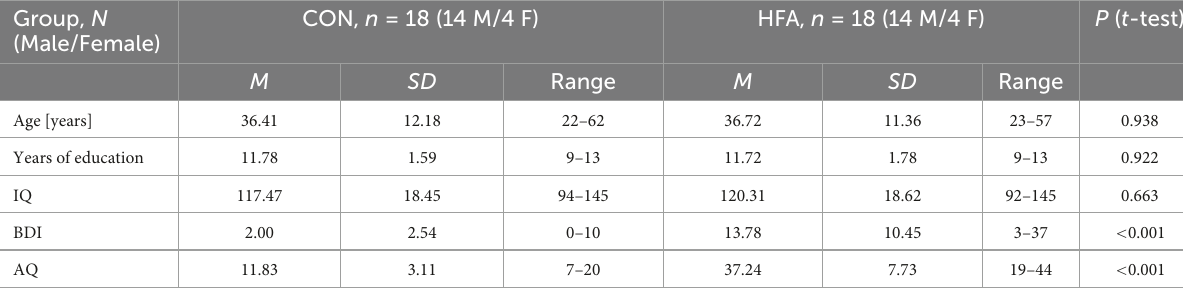
TABLE 1 Demographic information for both groups and group comparisons.